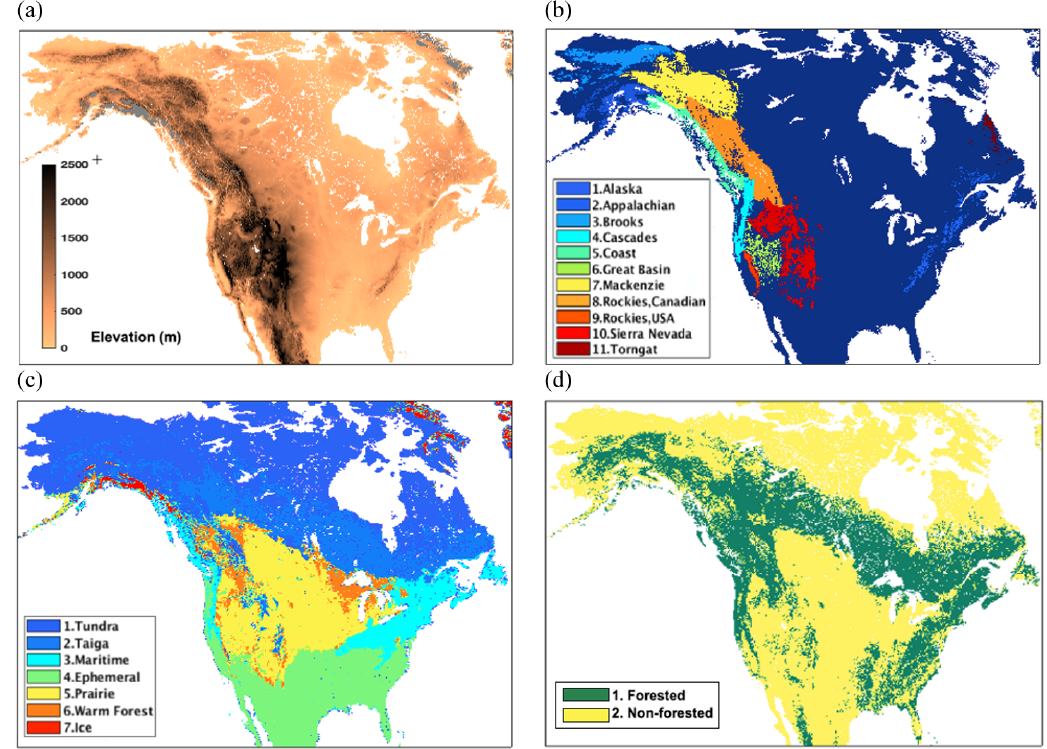
Figure 1. Snow Ensemble Uncertainty Project (SEUP) domain: (a) domain with terrain elevation (gray areas indicate the excluded glacier regions), (b) individual mountain domains, (c) individual snow class domains, and (d) land cover classification used in this